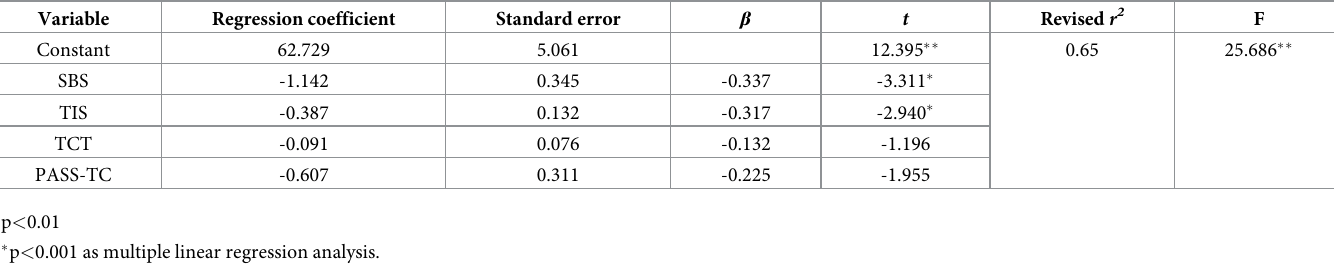
Table 4. Multivariate regression analysis of TUG influence on SBS, TIS, TCT, and PASS-TC results in participants.